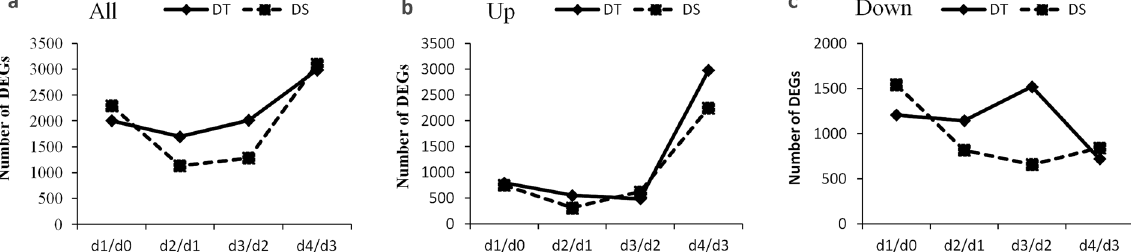
Figure 6. Dynamics of DEGs during time-course of drought stress in DT and DS. ( a ) Variation of all combined DEGs in DT and DS using the previous sampling date as control, ( b ) variation of up-regulated DEGs in DT and DS using the previous sampling date as control and ( c ) variation of down-regulated genes in DT and DS using the previous sampling date as